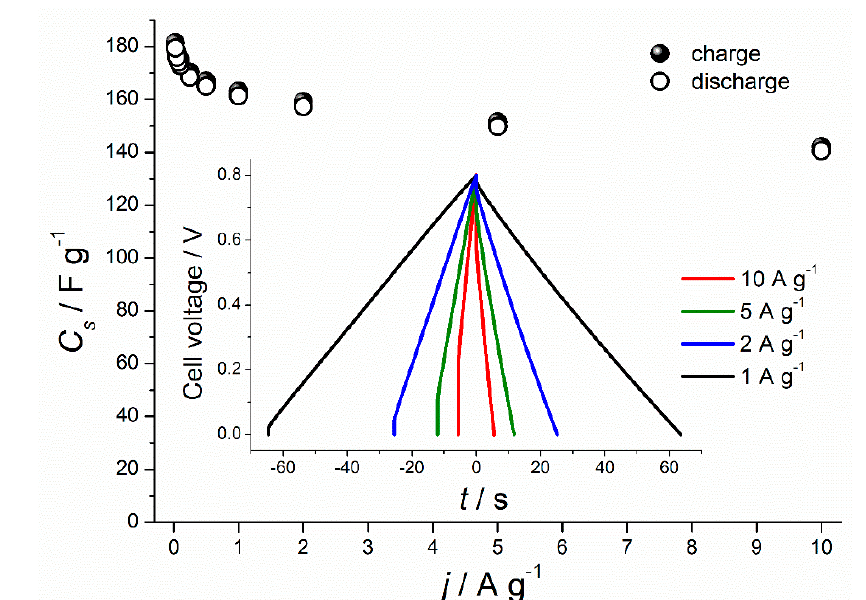
Figure 5. Specific capacitance values recorded for C–KOH sample at different current densities. Inset: